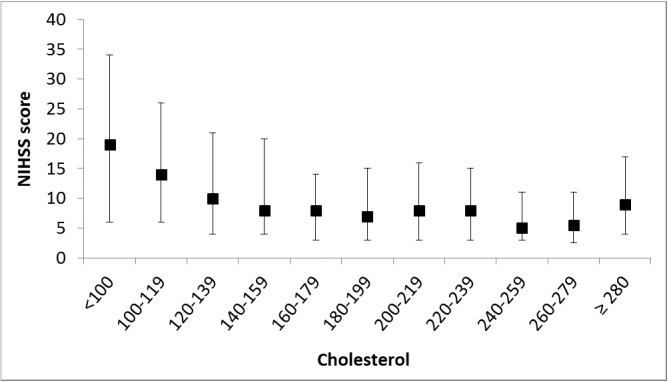
Correlation between initial NIHSS score (median [interquartile range]) and total cholesterol levels in 2444 ICH patients.(Pearson correlation coefficient = -0.74, p = 0.009).